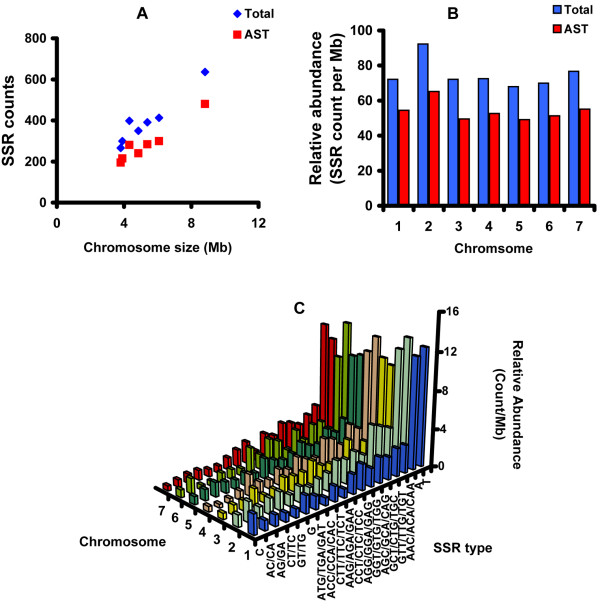
The distribution SSRs in different chromosomes in the N. crassa genome. A. The scatter plot for cumulative abundance of SSRs (y-axis) and size of chromosome (x-axis). Red squares represent the 19 abundant SSR types (AST) and blue diamonds represent all 963 SSR types (Total). B. Relative abundance of SSRs in different chromosomes. Red bars represent AST and blue bars represent Total. C. The relative abundances of total SSRs are presented by the chromosome and by the SSR type.